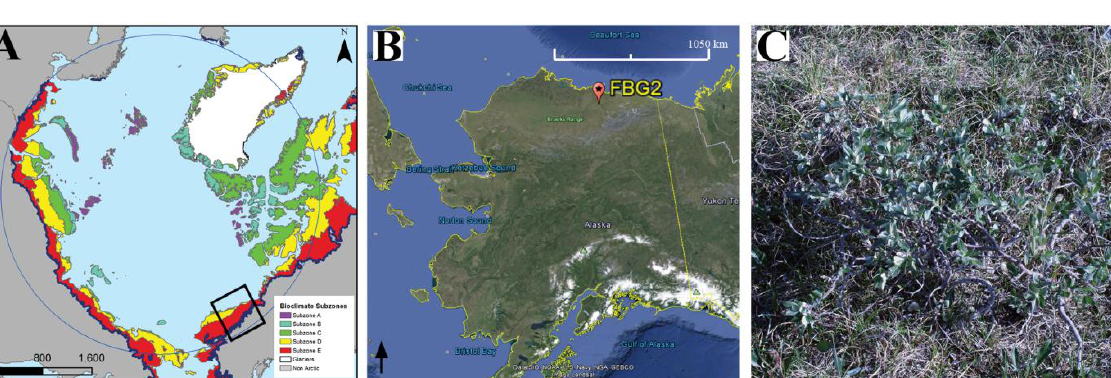
Figure 7. ( A ) The study location in respect to the bioclimate subzones of the circumpolar arctic vegetation map (CAVM) [43]; ( B ) Location of the sample plot FBG2 in the Alaskan Low Arctic. Image Source: Google Earth, 2013; ( C ) Photo of the prostrate dwarf deciduous shrub community measured at solar noon (sun zenith angle of